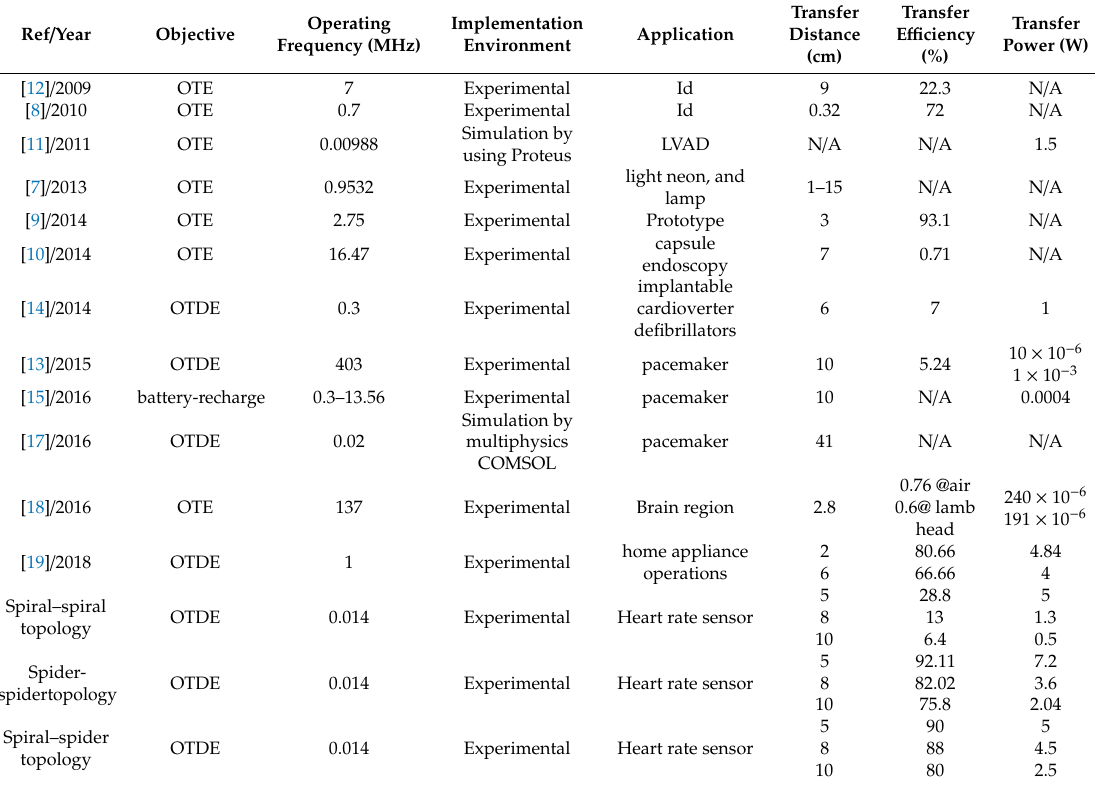
Table 6. Performance metrics from past